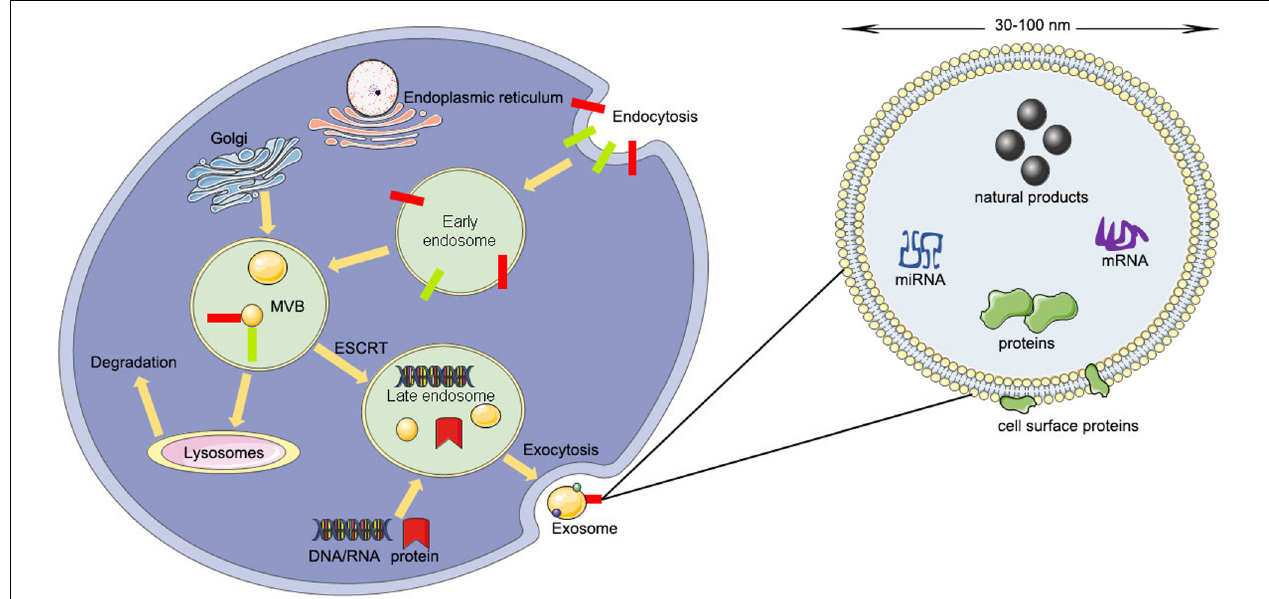
FIGURE 1 | The producing process and structural composition of exosomes (ESCRT, endosomal-sorting complex required for transport; MVB, multivesicular body).